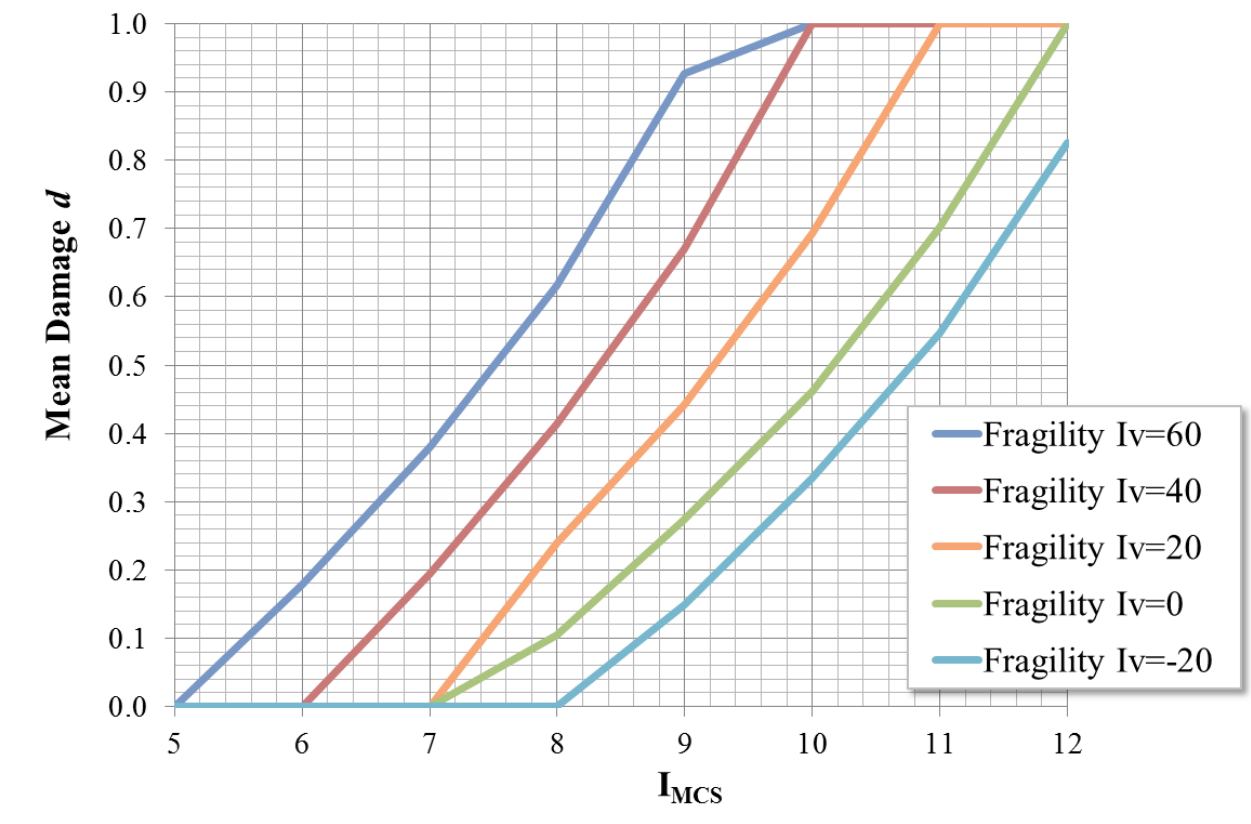
Figure 3. Fragility curves and vulnerability index I mean damage